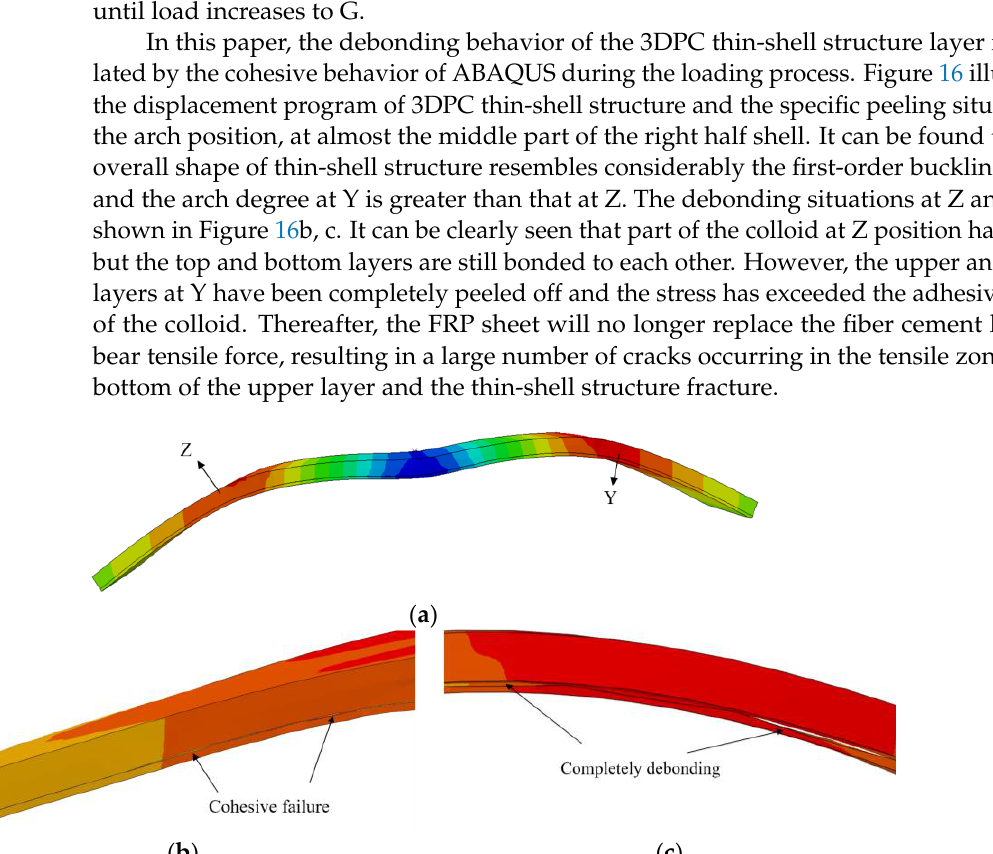
Figure 15. Load-displacement curve.